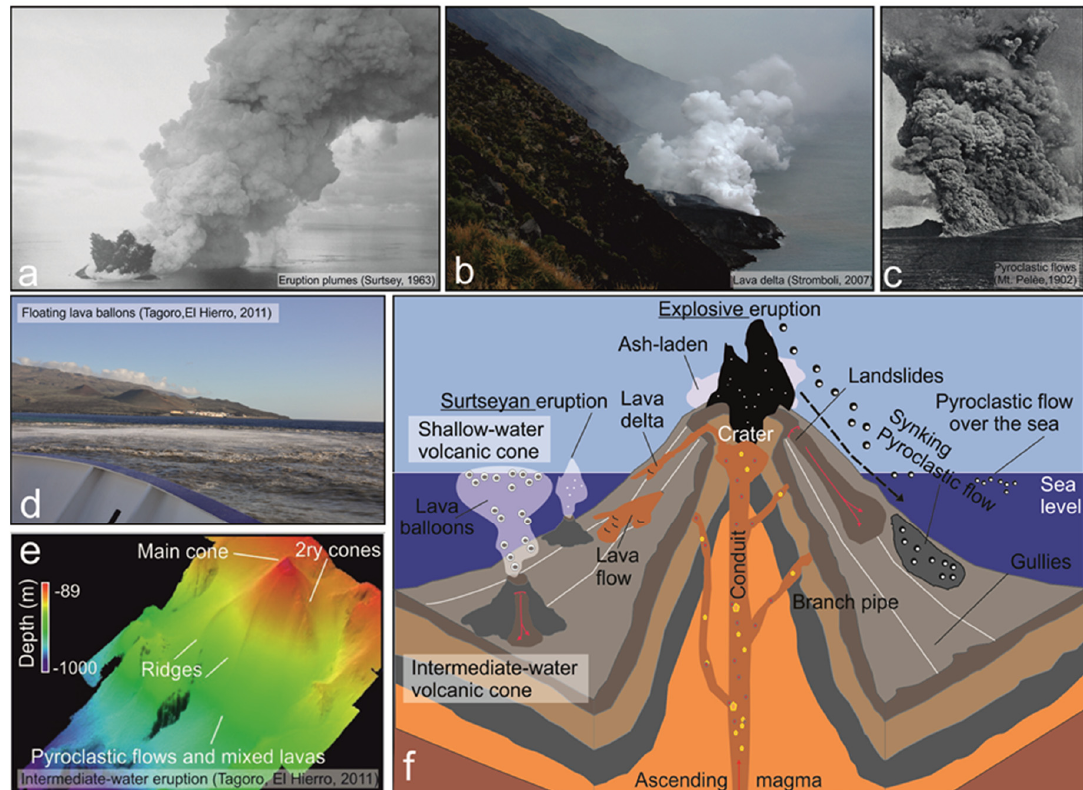
Figure 5. Main types of eruptions examples: ( a ) Historical image of surtseyan eruption plumes from Surtsey (Iceland) in 1963 (image from National Oceanic and Atmospheric Administration, from https://commons.wikimedia.org/wiki/File:Surtsey_eruption_2.jpg, accessed on 03 June 2021); ( b ) emplacement of the 2007 lava delta at Stromboli (image from Rolf Cosar, downloaded from https://commons.wikimedia.org/wiki/File:Stromboli-Lavadelta-2007-03-10.JPG, accessed on 03 June 2021); more details on the 2007 submarine eruption at Stromboli can be found in [107]; ( c ) pyroclastic flow occurred on 16 December 1902, during a volcanic eruption of Mt. Pelée in Martinique (image from A. Lacroix, https://commons.wikimedia.org/wiki/File:Photographie_du_nuage_noir_du_16_d%C3%A9cembre_1902_lors_de_l%27%C3%A9ruption_de_la_Montagne_Pel%C3%A9e_en_Martinique.jpg, accessed on 3 June 2021); ( d ) floating volcaniclastic materials and gas emissions during the Tagoro volcanic eruption offshore El Hierro in 2011 (image courtesy of Eugenio Fraile, IEO); ( e ) 3D bathymetric map of the Tagoro volcano showing the main morphological characteristics; more details on this submarine eruption can be found in [108,109]; ( f ) 3D simplified sketch of the main types of eruptions affecting insular volcanoes.